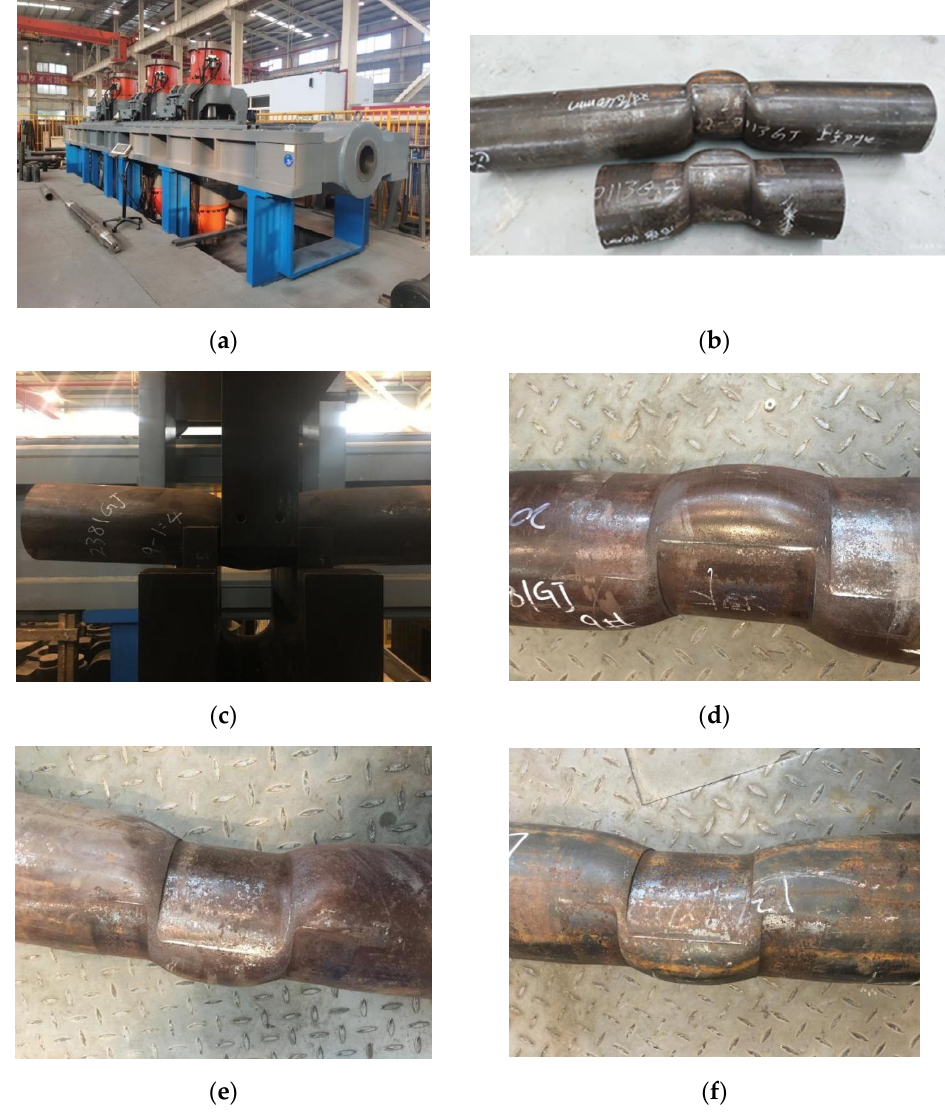
Figure 3. Morphology of casing after shear tests: ( a ) test device; ( b ) topography contrast; ( c ) shear test process; ( d ) #1 casing appearance after shear test; ( e ) #2 casing appearance after shear test; ( f ) 125